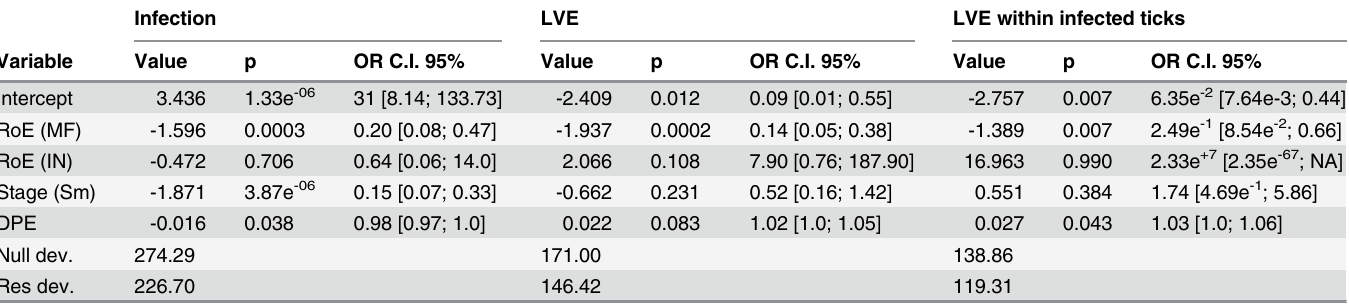
Table 7. Logistic regression model B — Effect of route of exposure (Pig feeding versus inoculation and membrane feeding) with high titres of virus, controlling for tick stage and days post exposure, in infection (n = 206), likelihood of virus excretion (LVE) (n = 206) and likelihood of virus excre- tion within the infected ticks (LVE within the infected ticks) (n =